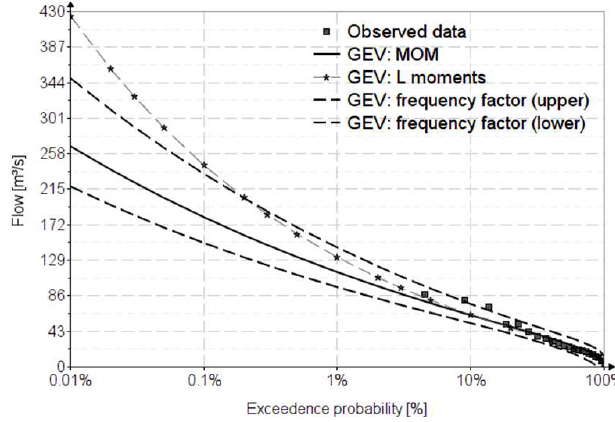
Figure 10. GEV distribution.